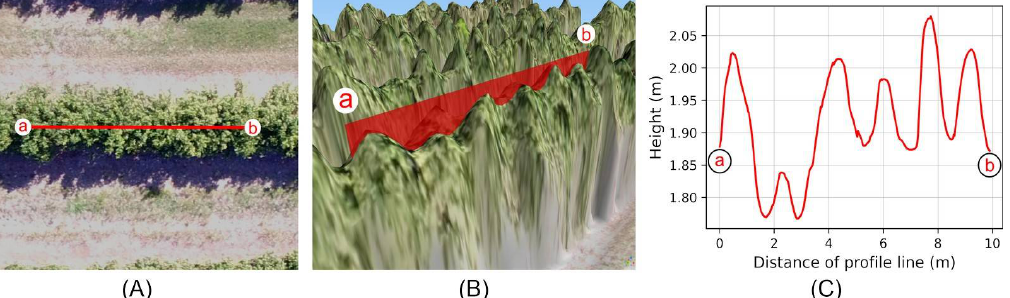
Figure 2. Canopy Height Model (CHM) derived from the photogrammetry process applied to UAV images. ( A ) refers to the true-color composite; ( B ) refers the 3D perpective and, ( C ) a canopy height profile.